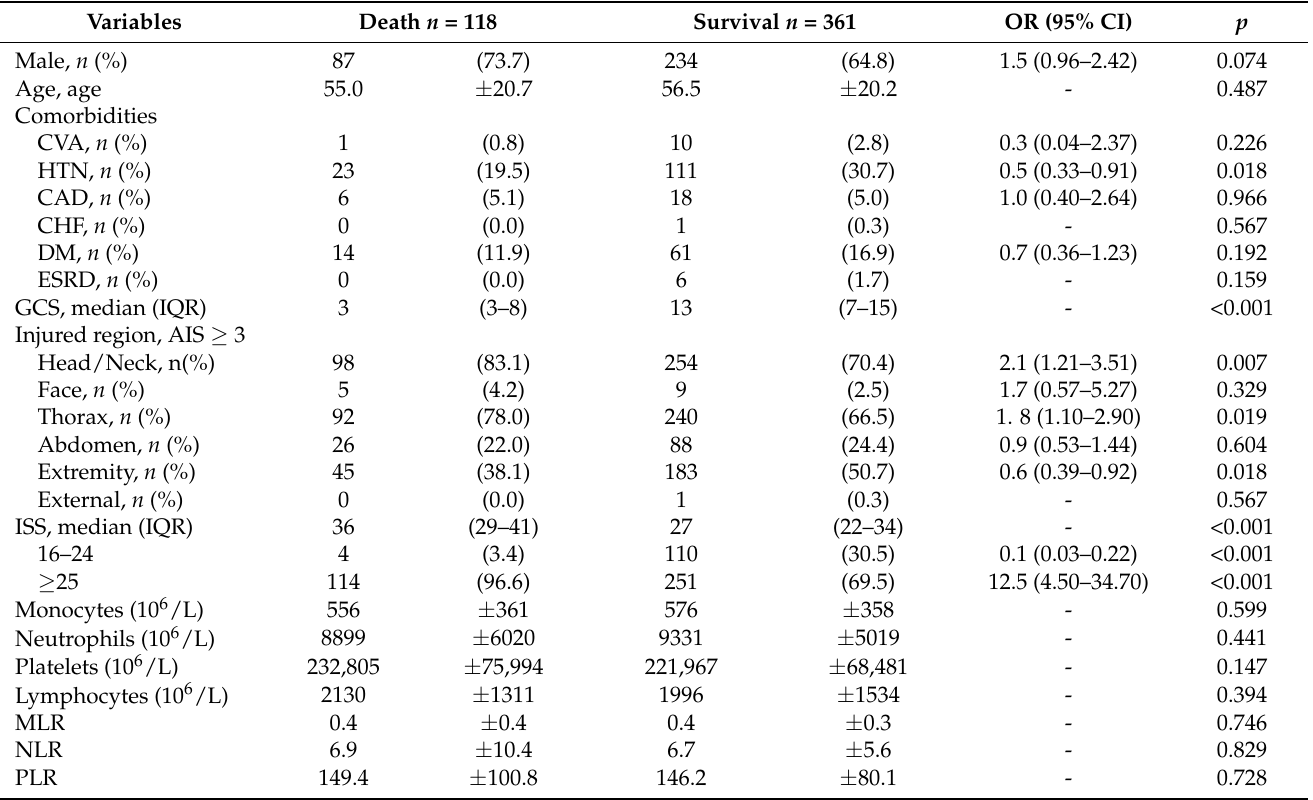
Table 1. Patient and injury characteristics of the deceased and surviving patients with